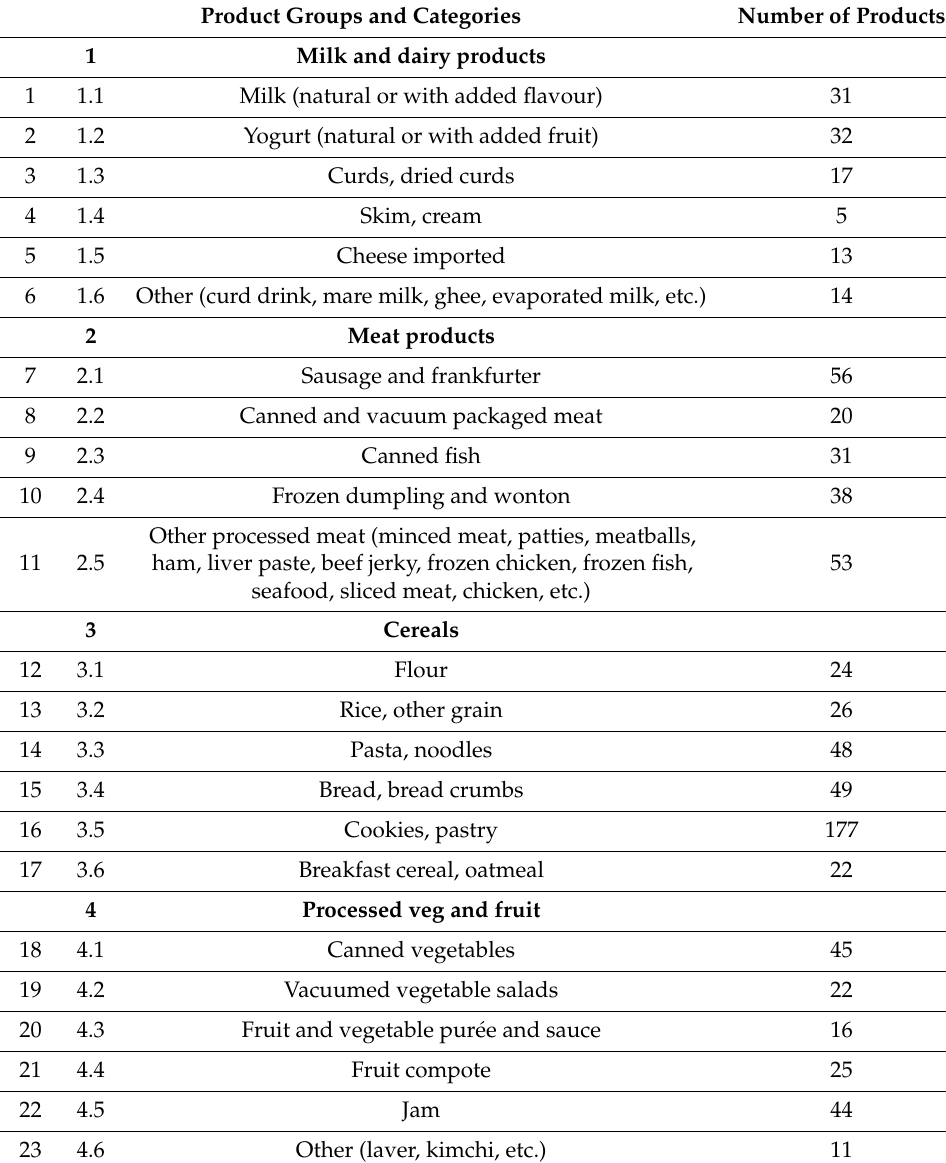
Table A1. Product groups and categories covered in the